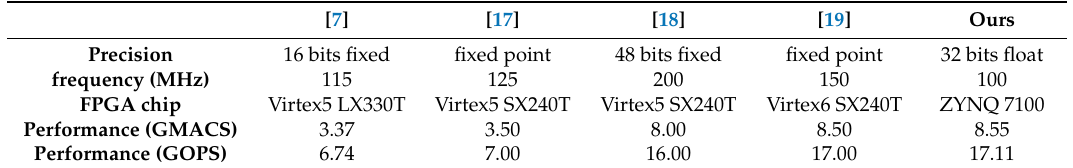
Table 6. Comparison to previous implementations.